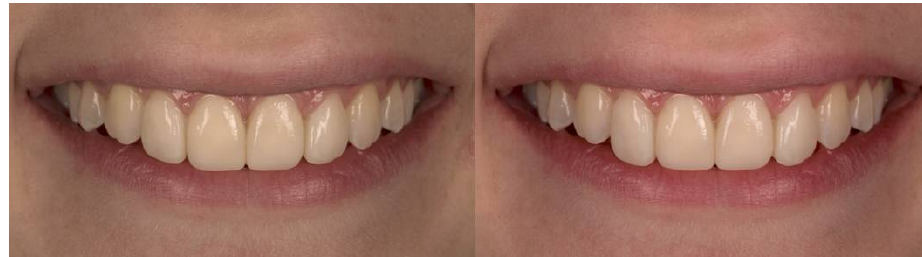
Figure 3. Incisal step of 1 and 0 mm .